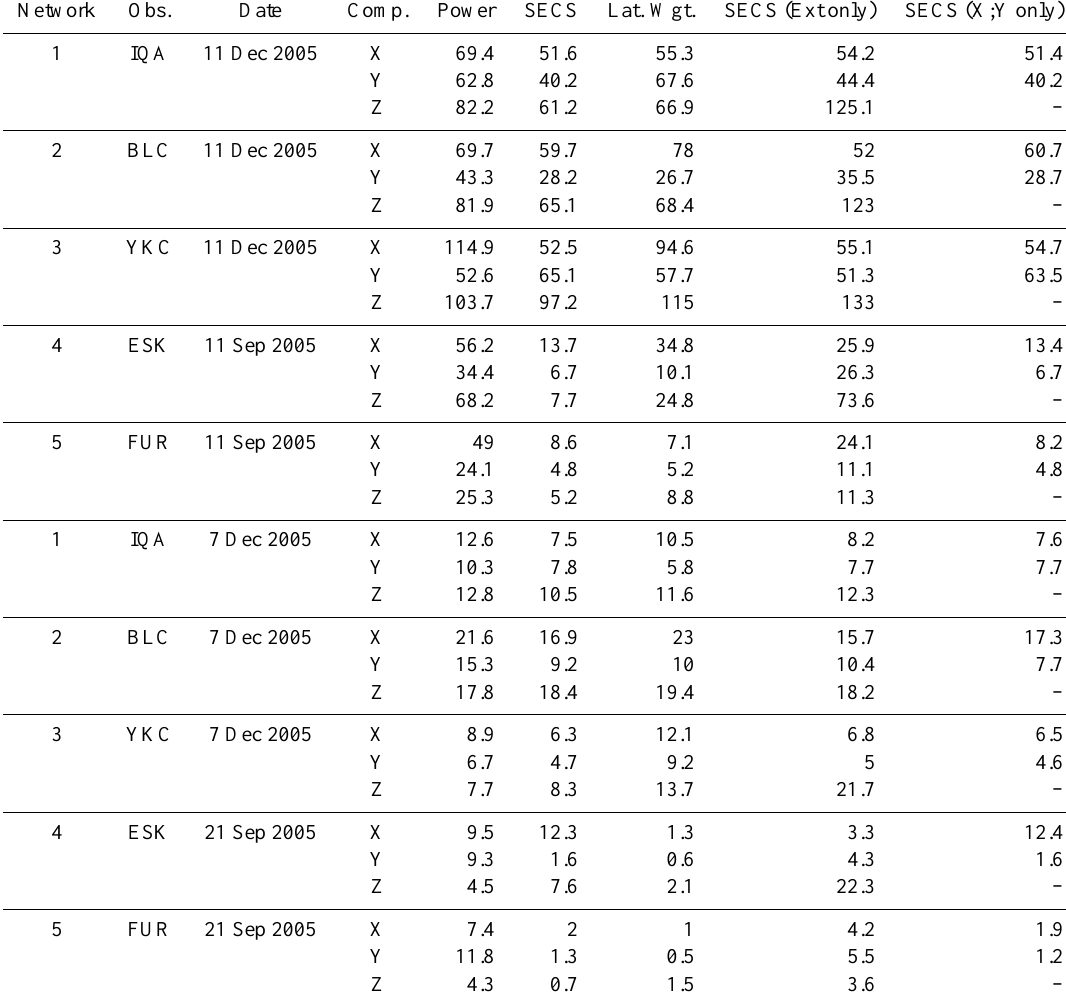
Table 1. RMS errors of the Power, SECS, Latitudinal Weighting, SECS (External only) and SECS (X and Y only) estimates for the five networks, calculated over a period of twenty-four hours. Analysis is presented for a magnetically disturbed day (11 December 2005; 11 September 2005) and magnetically quiet day (7 December 2005; 21 September 2005), depending on the availability of data within each network. For Network 1, the observatories used for latitude weighting are GDH and NAQ; Network 2 uses CBB and FCC; Network 3 uses CBB and MEA; Network 4 uses LER and HAD; Network 5 uses WNG and AQU. Network